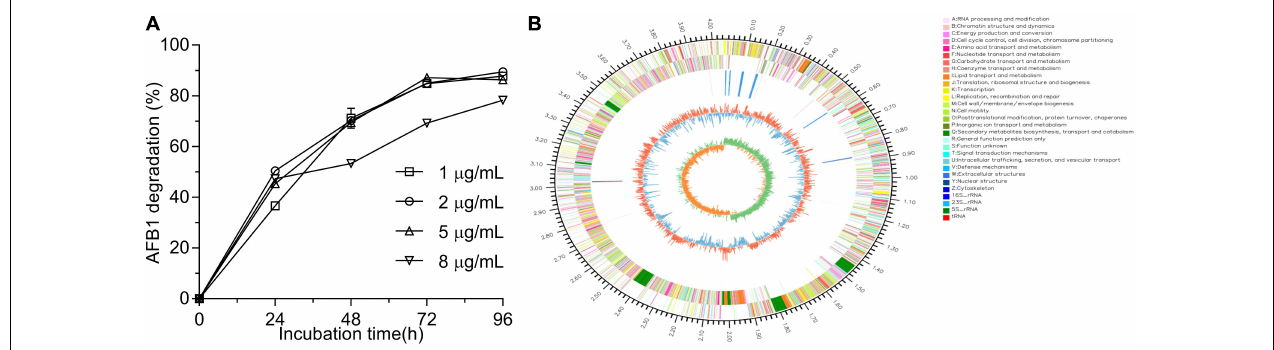
FIGURE 1 | Aflatoxin B1 (AFB1) degradation mediated by Bacillus amyloliquefaciens WF2020 at different concentrations of AFB1 (A) and circular representation of the complete genome of B. amyloliquefaciens WF2020 (B) . From outermost to innermost circle: circle 1, genome size; circle 2, genes on forward strand; circle 3, genes on reverse strand; circle 4, rRNA and tRNA; circle 5, GC content; and circle 6, GC skew.